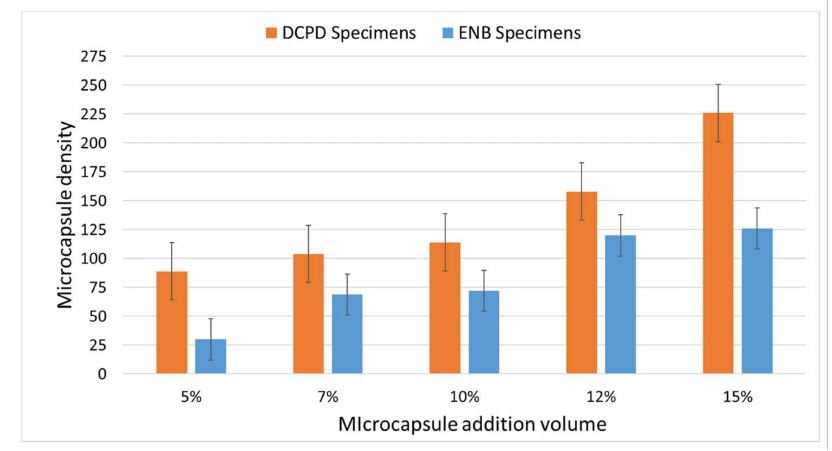
Figure 13. Total microcapsule density with respect to their volume addition.